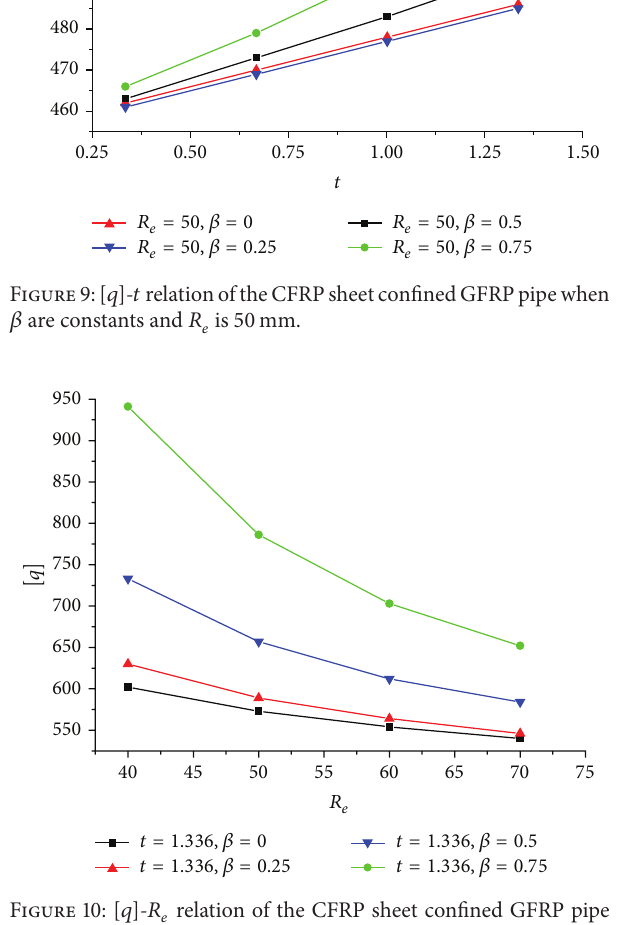
Figure 8: [𝑞] - 𝑅 𝑒 relation of the CFRP sheet confined GFRP pipe when 𝑅 𝑒 /𝑡 are constants.